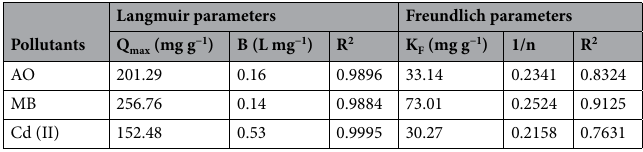
Table 2. Parameters of isotherm model for adsorption of AO, MB, and Cd (II) on ZF-NPS.